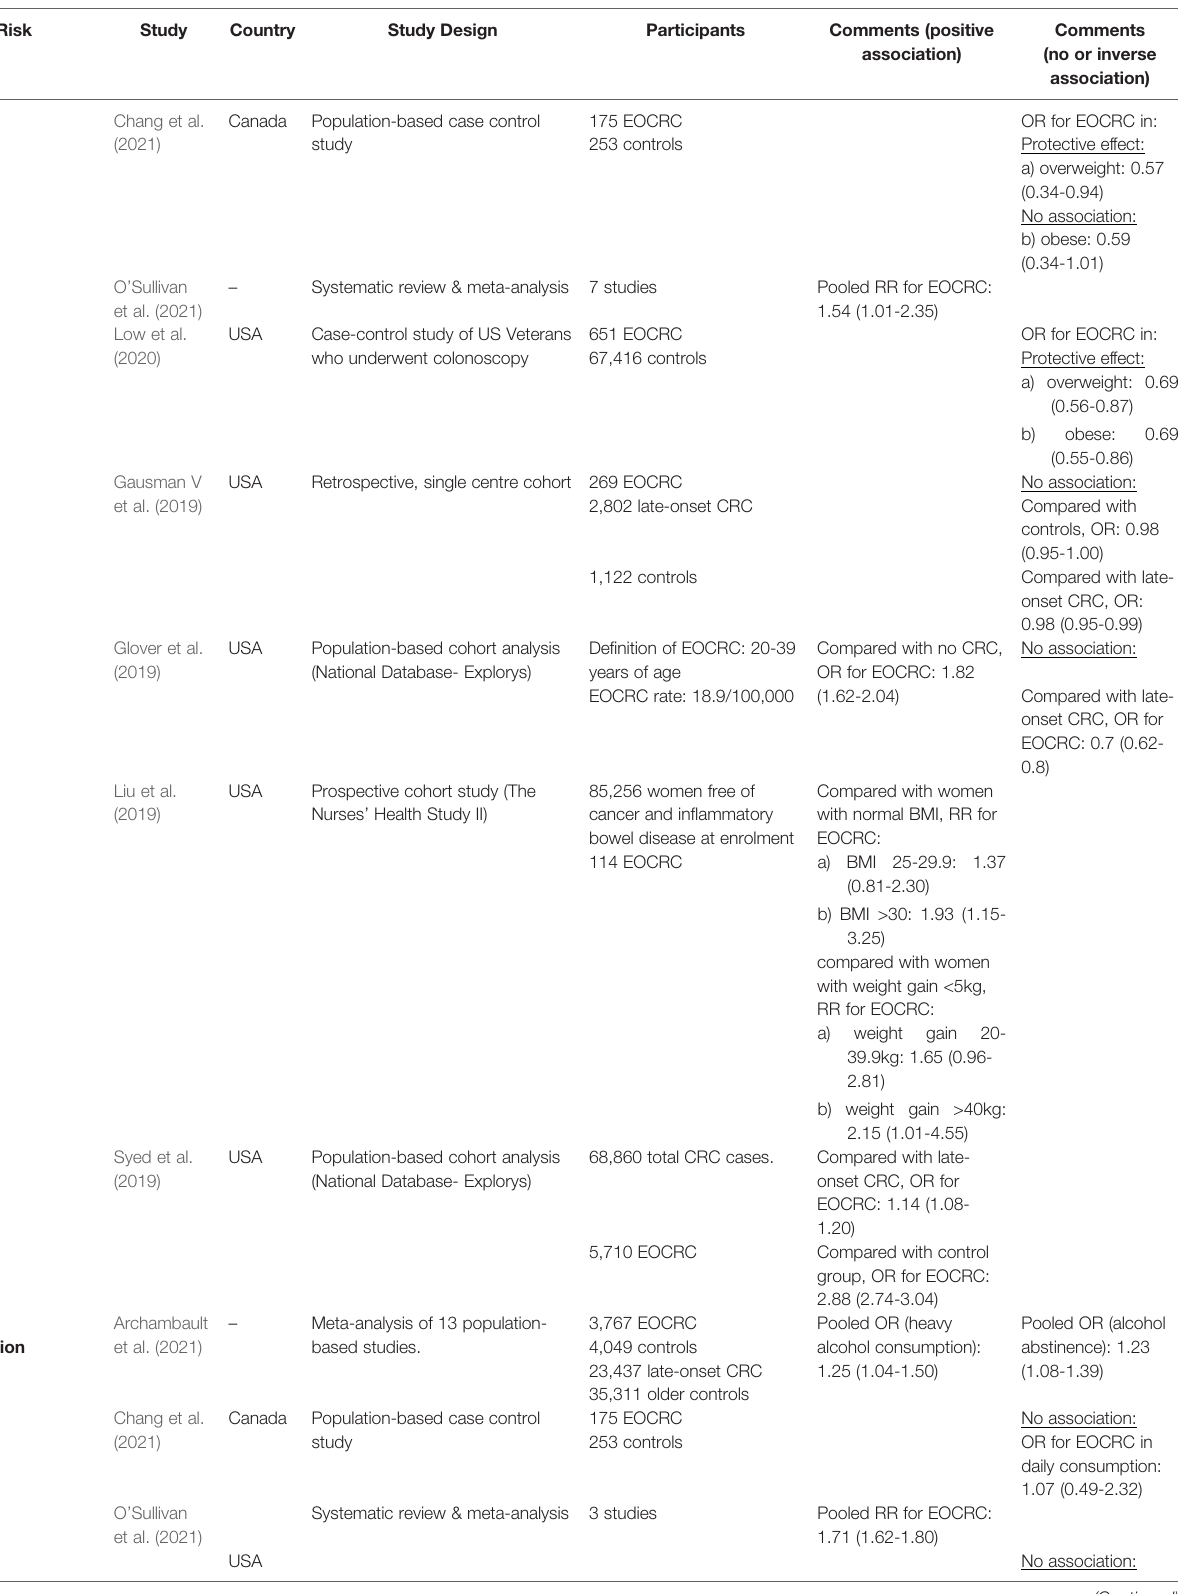
TABLE 1 | Recent published studies on the potential risk factors for